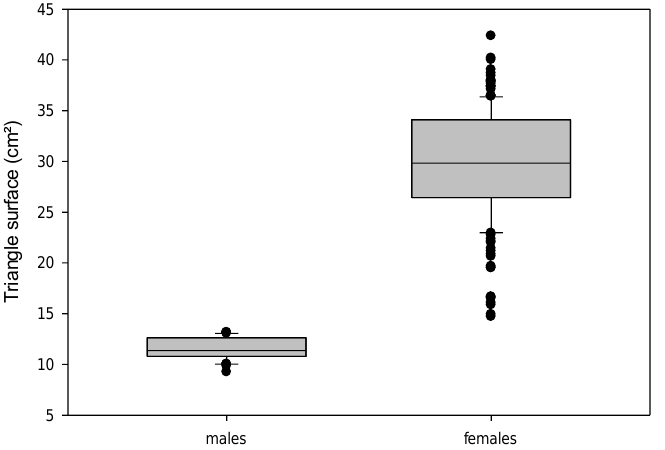
Figure 3. Comparison of the triangle surface (cm 2 ) in adult males ( n = 40) and females ( n = 198). Xenopus laevis (α < 0.001).